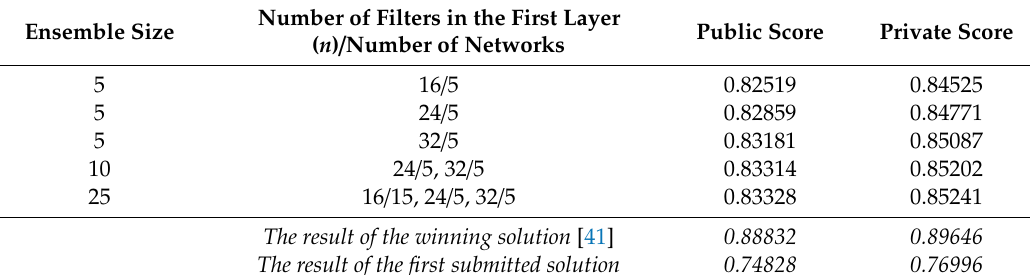
Table 1. An overview of the results for di ff erent